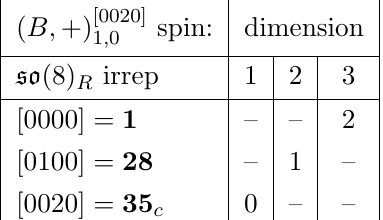
Table 19 . All possible conformal primaries in S 2 (cid:2) S 2 and S 3 (cid:2) S 3 corresponding to the ( B; +) [0020] superconformal multiplet.